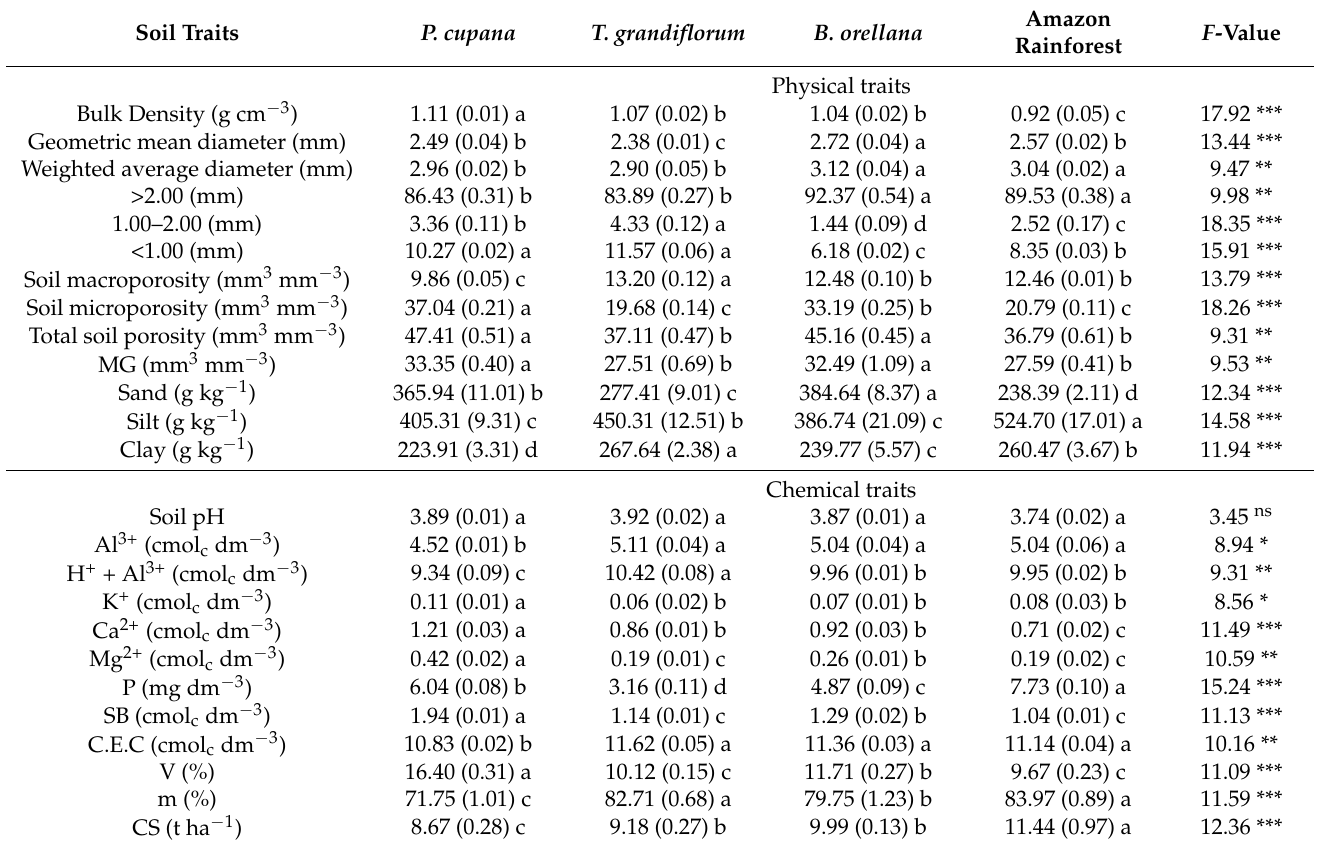
Table 1. Soil traits in different land use from Brazil’s Legal